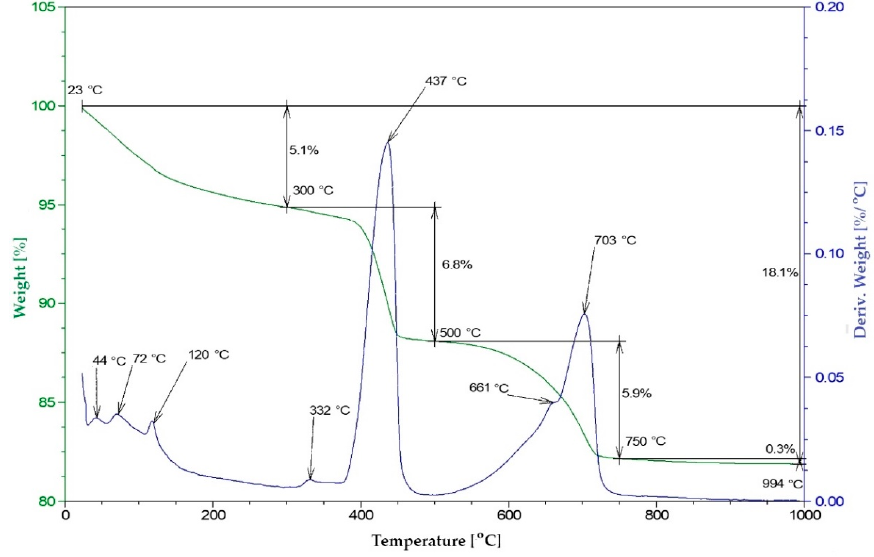
Figure 6. TG and differential thermal analysis (DTA) thermogram of R ‐ MUD/Ca(OH) 2 samples after 7 days of curing.